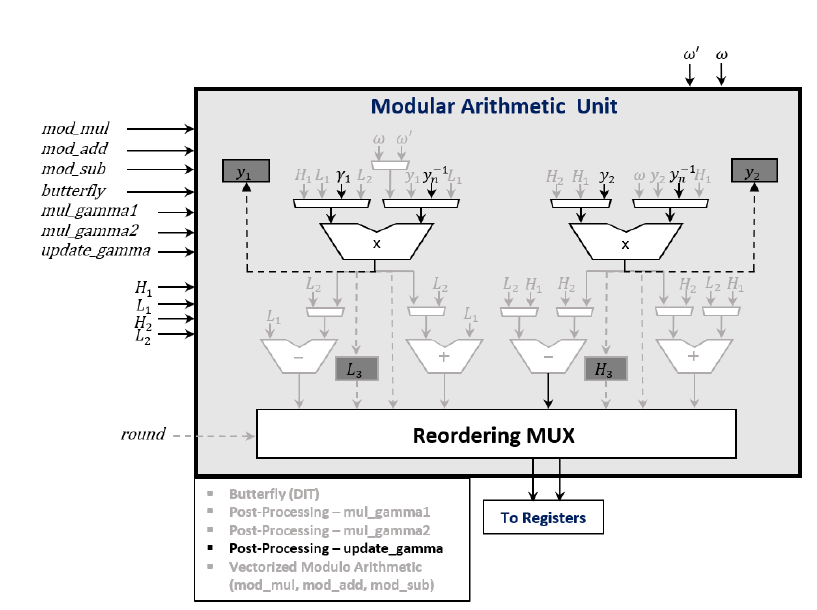
Figure 10: Modular Arithmetic Unit – Post-Processing Operation ( mul _ gamma 1, mul _ gamma 2, update _ gamma )